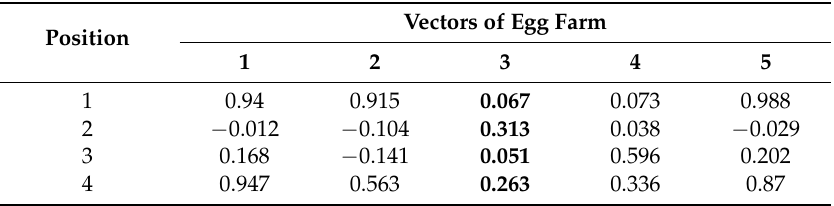
Table 15. Vectors after mutation of vector positions of egg farm.